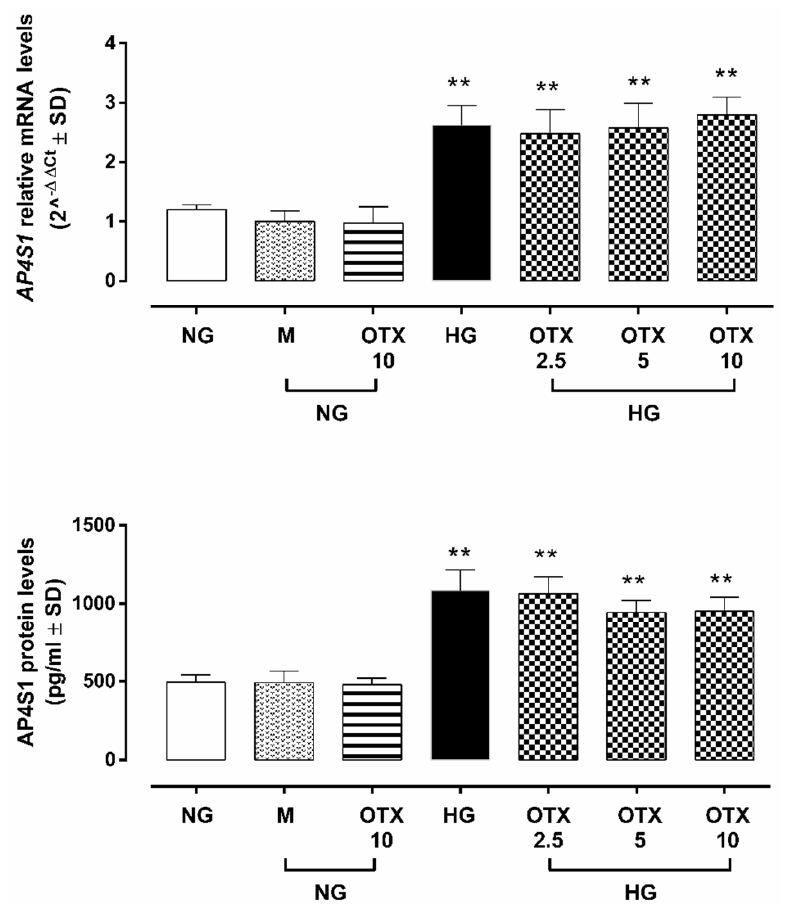
Figure 2. AP4S1 expression in ARPE-19 cells. AP4S1 relative mRNA levels, reported as 2 ˆ − ∆∆ Ct ± SD and quantized by using GAPDH as control along with AP4S1 protein levels, reported as pg/mL ± SD. N = 9 observations per group (three independent experiments, each performed in triplicate). ** p < 0.01 vs. NG; NG, normal glucose (5 mM) + vehicle; M, mannitol (30 mM); HG, high glucose (35 mM) + vehicle; OTX 2.5, OTX 2.5 µ M; OTX 5, OTX 5 µ M; OTX 10, OTX 10 µ